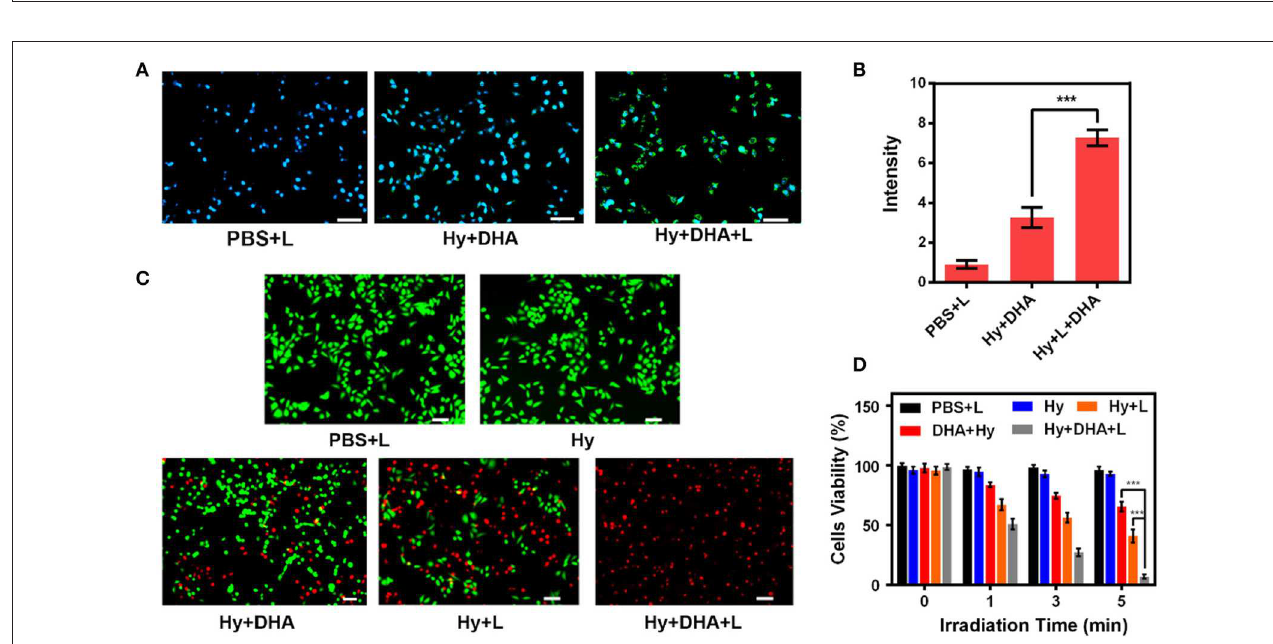
FIGURE 3 | (A) DCFH-DA (2,7-Dichlorodi-hydrofluorescein diacetate) staining in 4T1 cells upon different treatments. Scale bar: 50 µ m. (B) Fluorescence intensity of DCFH-DA from (A) . (C) Fluorescence images of 4T1 cells stained with FDA (live cells, green fluorescence) and PI (dead cells, red fluorescence) after incubation with different formulations. (D) Cell viability of 4T1 cells cultured in the presence of various formulations after laser irradiation. *** p < 0.005.